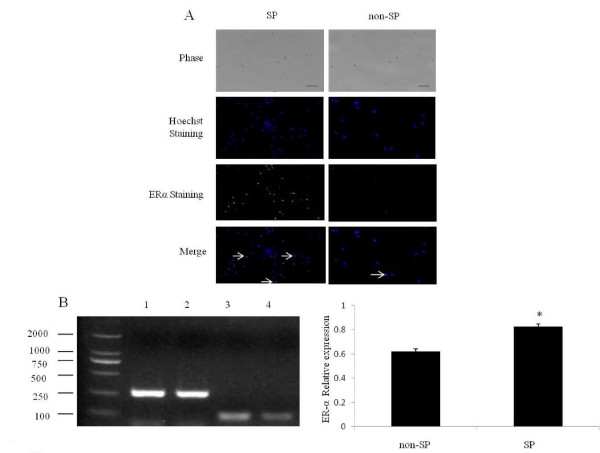
Expression of ESR1 in SP and non-SP cells. Figure 3A. Immunocytochemical analyses of ESR1 expression in SP and non-SP cells. Nuclear Hoechst staining (blue) and immunofluorescent labeling of ESR1 (green) were merged. Scale bar, 100 μm. The arrows indicate ESR1 immunopositive cells (Hoechst and ESR1 staining merged). Figure 3B, C. RT-PCR analyses of ESR1 expression in SP and non-SP cells. 1. SP Actin; 2. Non-SP Actin; 3. SP ESR1; 4. Non-SP ESR1. *P < 0.05.